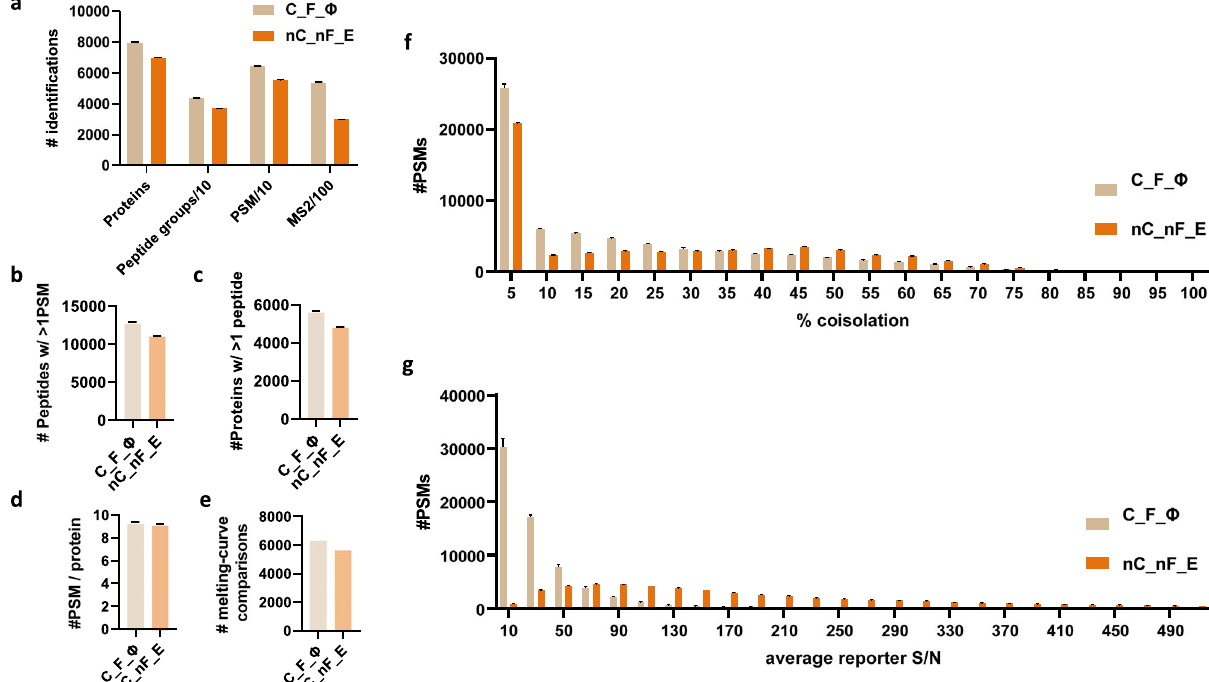
Fig. 5 Improvements in the performance of C_F_ Φ compared to nC_nF_E shown in the fractionation experiment. a Proteomic identi fi cations (proteins, peptide groups10 -1 , PSM10 -1 , and MS 2 scans100 -1 ) from C_F_ Φ and nC_nF_E. b Number of peptides with >1 PSM, c number of proteins with >1 peptides, d number of PSMs per protein, and e number of melting-curve comparisons for C_F_ Φ and nC_nF_E. f Histogram (binwidth = 10) of PSM % coisolation for C_F_ Φ and nC_nF_E . g Histogram (binwidth = 20) of average reporter ion signal to noise (SN) for C_F_ Φ and nC_nF_E. The error bars represent the standard deviation ( n = 3) for a – d , and f , g